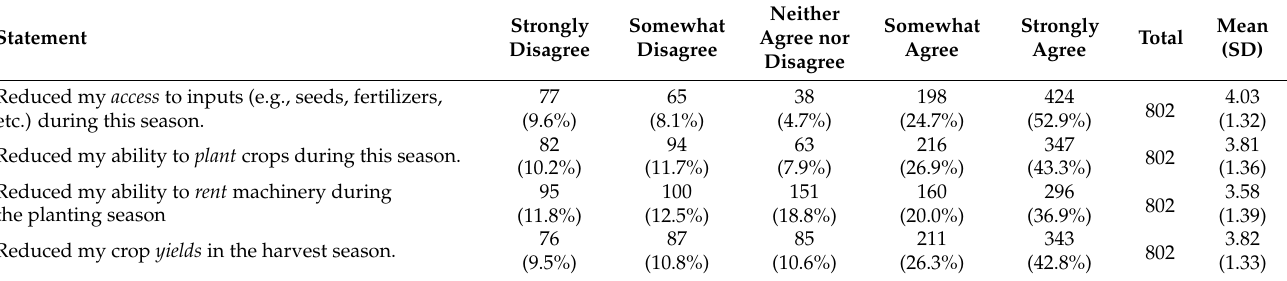
Table 3. Thinking about your experience of what has occurred due to COVID-19, please indicate your agreement or disagreement with the following statements. COVID-19 has . . . .